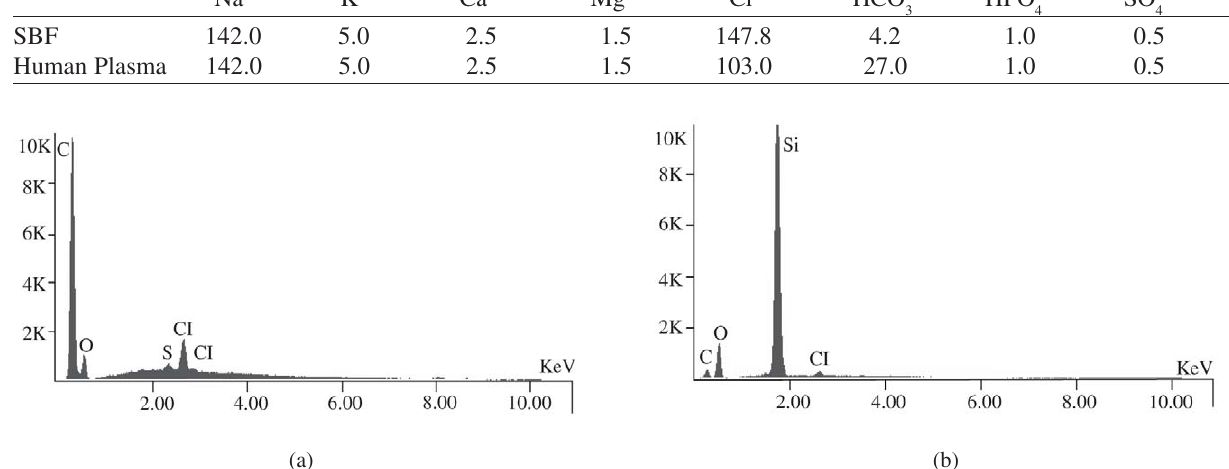
Figure 1. EDS of collagen fibers: a) from control group, b) chemically treated with TEOS for